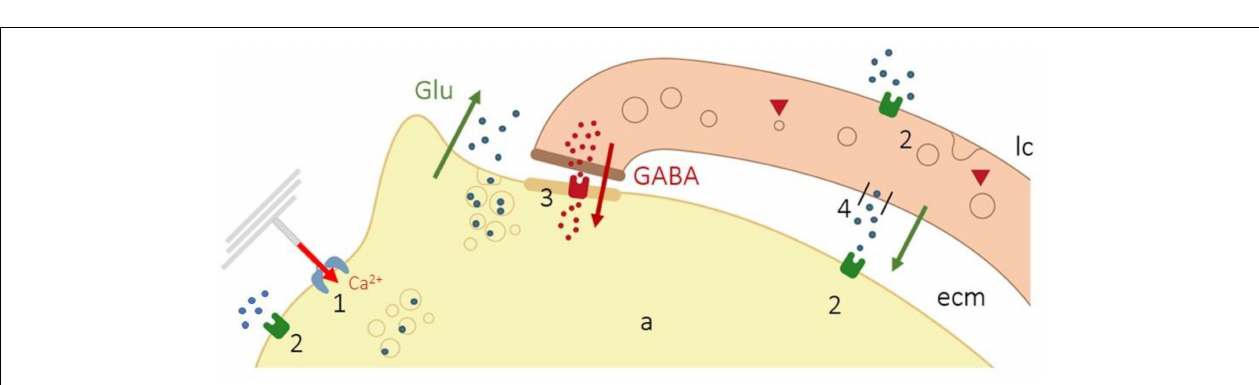
FIGURE 3 | (A) Schematic representation of a Pacinian corpuscle showing the corpuscular structures that are modified by a force to generate the action potential. a, axon; c, capsule; ic, inner core; il, intermediate layer; lc, lamellar cells; oc, outer core; Sc, Schwann cells. (B) Schematic transversal section of a Pacinian corpuscle showing all cell structures potentially involved in mechanotransduction.